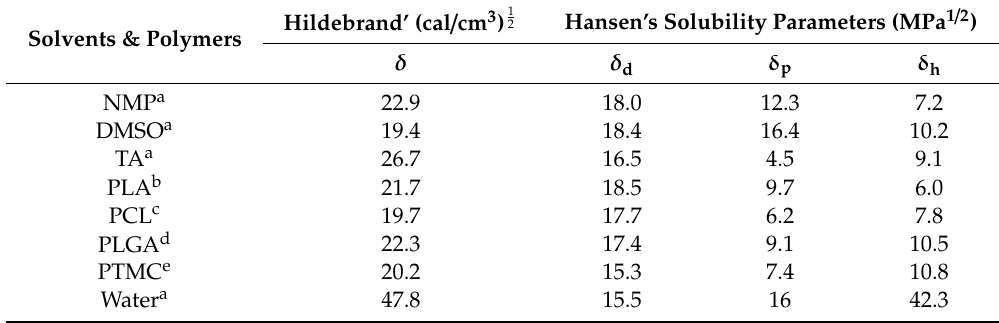
Table 1. Solubility parameters of solvents and polymers.